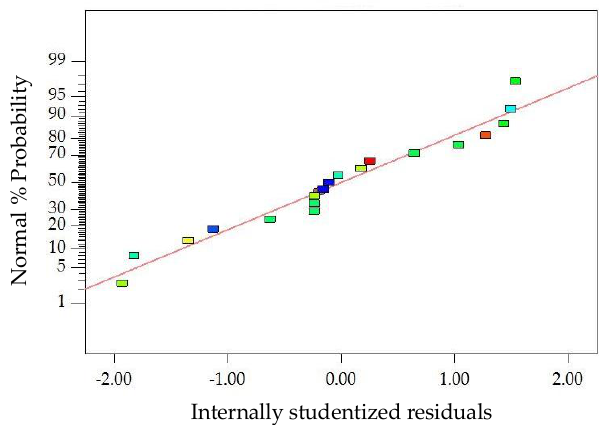
Figure 10. Diagnostics of statistical model: normal plot of residuals for VA .